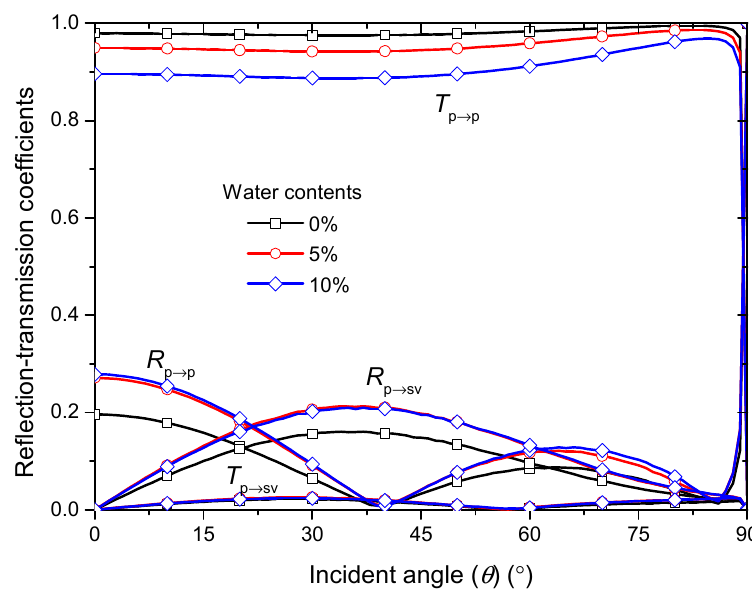
Figure 7. Reflection–transmission coefficients versus the incident angle θ when the P wave impinges on a single filled joint with a thickness of 10 mm. The incident wave has the frequency of 50 Hz.